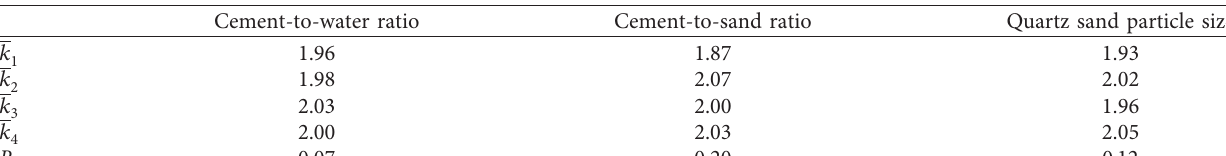
Table 6: Range analysis of density.